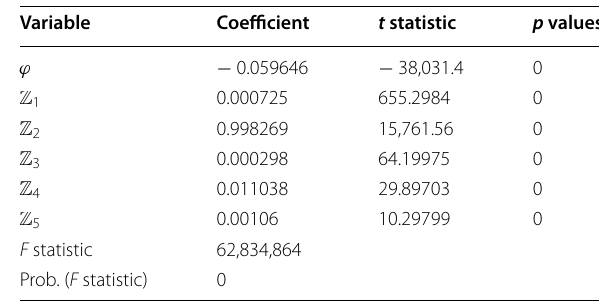
Table 3 Result of relevance